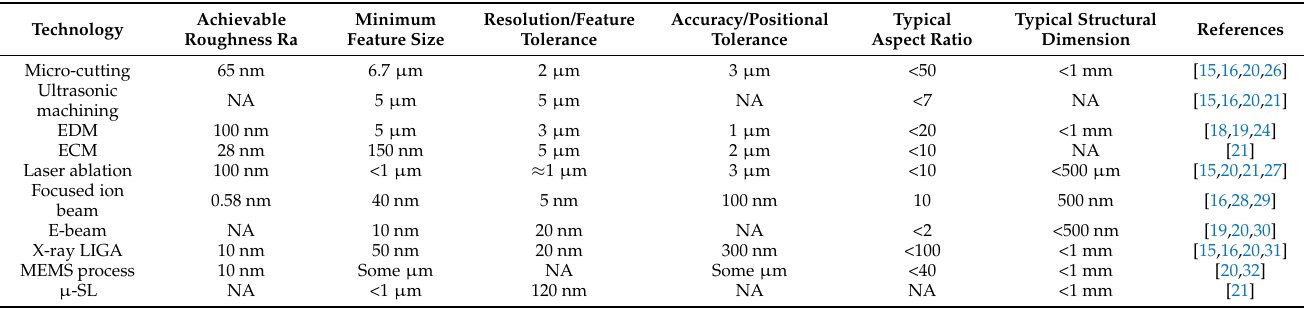
Table 1. Comparison of master fabrication